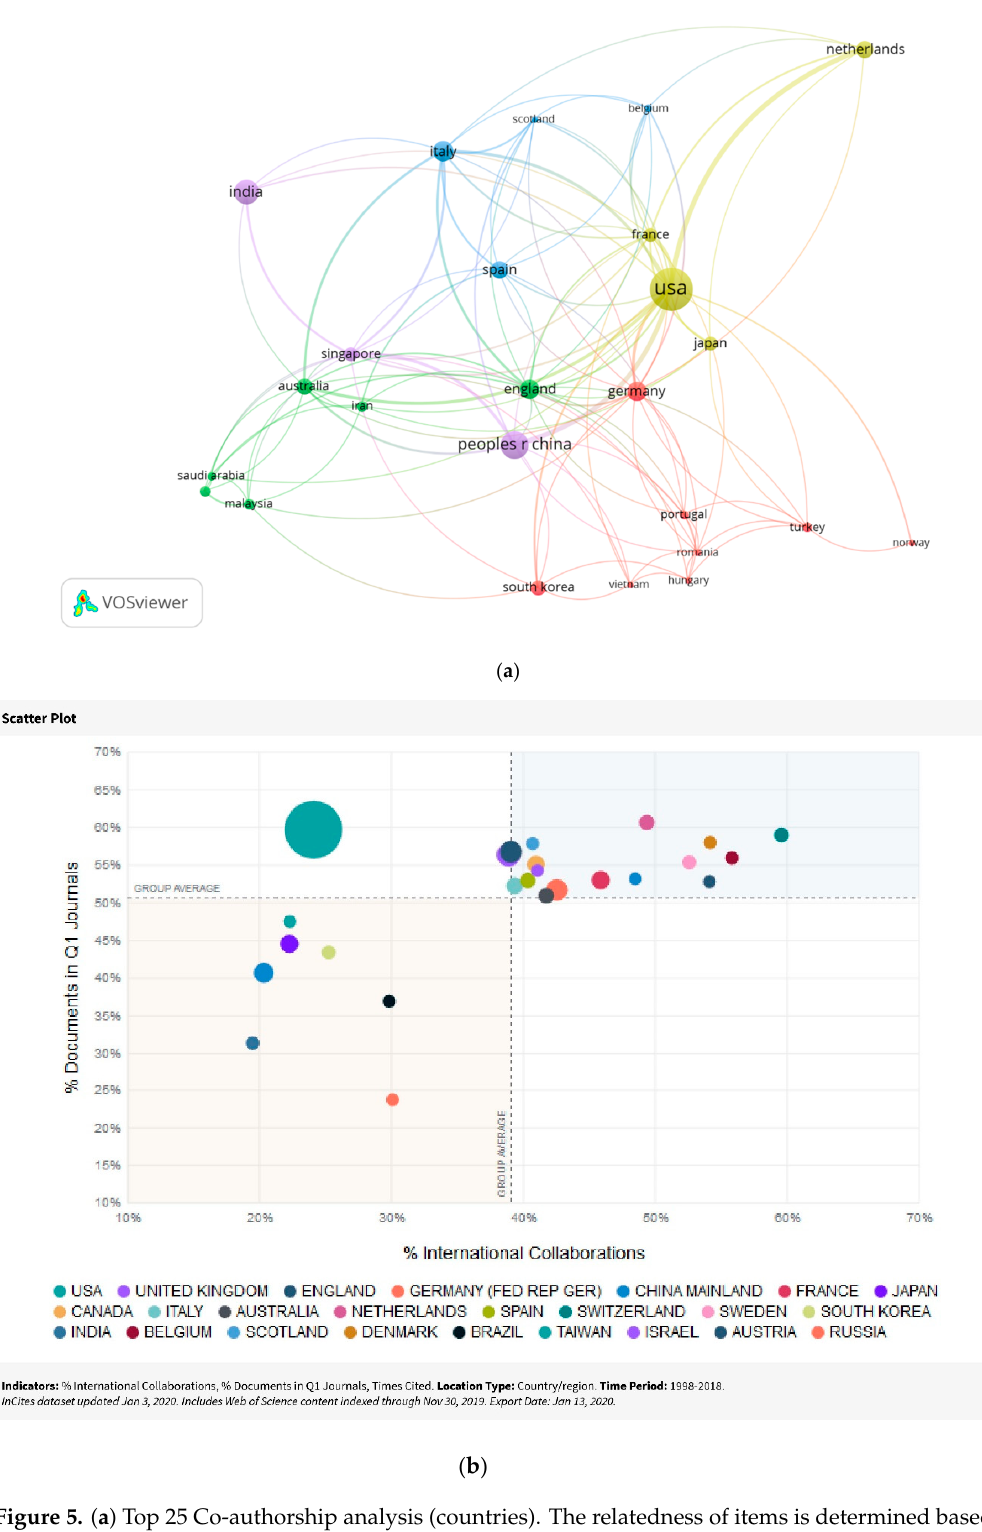
Table 3. Top 25 International Collaborations/Organizations and Record Count. Minimum number of documents of a country (5) and minimum number of citations of a country (5). Ranking